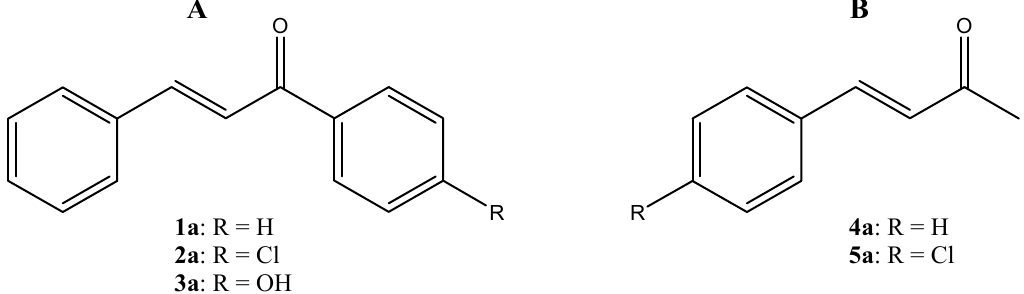
Figure 1. Chemical structures of substrates (from 1a to 5a: A , chalcones; B , α , β -unsatured ketones) with di ff erent substituents (R) used for checking NCY ene-reductase activity. The following microbiological culture media were used: YEPG: yeast extract 10 g L